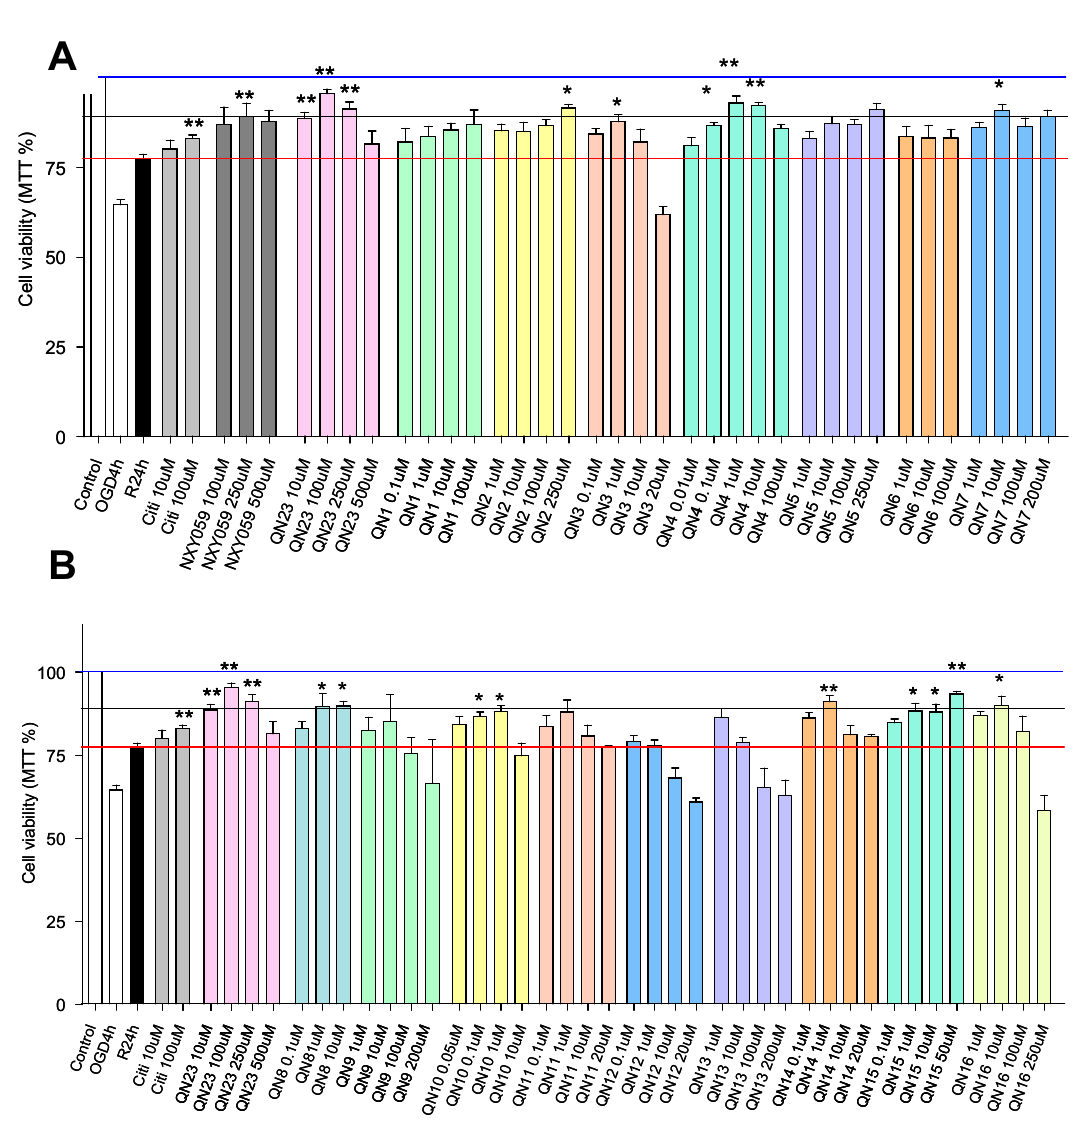
Figure 2. Effect of QNs 1–16 on primary neuronal cultures exposed to OGD and subsequent reoxygenation. Bar chart showing the percentage of cell viability at 24 h of normoxic and normoglycemic recovery after 4 h of OGD, either untreated (R24h) or treated with different concentrations ( μ M) of citicoline, NXY-059, QN23, or QNs 1–7 ( A ) and QNs 8–16 ( B ) at the onset of the recovery period. The value induced by 4 h of OGD without recovery period (OGD4h) is also indicated. Cell viability of control cells (1.916 ± 0.07 AU) was considered as 100% (blue line). Bars represent the average of four to eight independent experiments; error bars representing the SE. * p < 0.05, and ** p < 0.01 compared with R24h (red line) by Dunnett’s post-test after ANOVA, when it was significant. Black line shows the increase of cell viability induced by the reference nitrone NXY-059 (250 μ M). Statistical significances below R24h value were not shown.